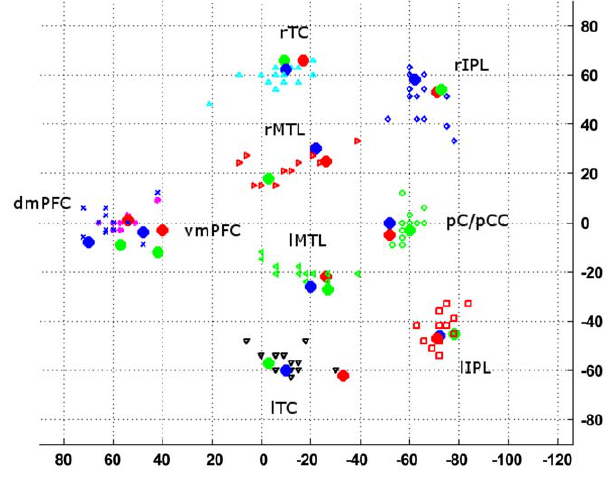
Figure 1. Location of the ROIs used in the present analysis. Large blue filled dots: centers for TalFr; large red filled dots: centers for TalFox; large green filled dots: centers for gICA; green circles: pC/PCC; red squares: lIPL; blue diamonds: rIPL; blue crosses: dmPFC; magenta astrixes: vmPFC; black down-pointing triangles: lTC; cyan up-pointing triangles: rTC; green left-pointing triangles: lMTL; red right-pointing triangles: rMTL.